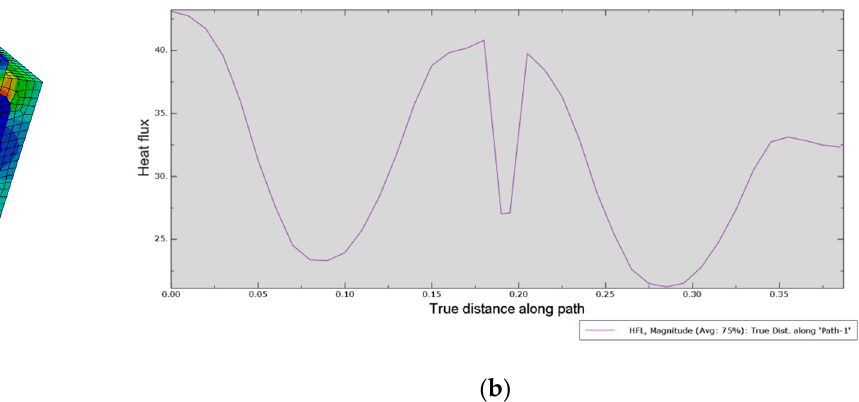
Figure 3. ( a ) Left calculation path in the 3D model; ( b ) heat flux (W·m − 2 ) of each node in the left path.